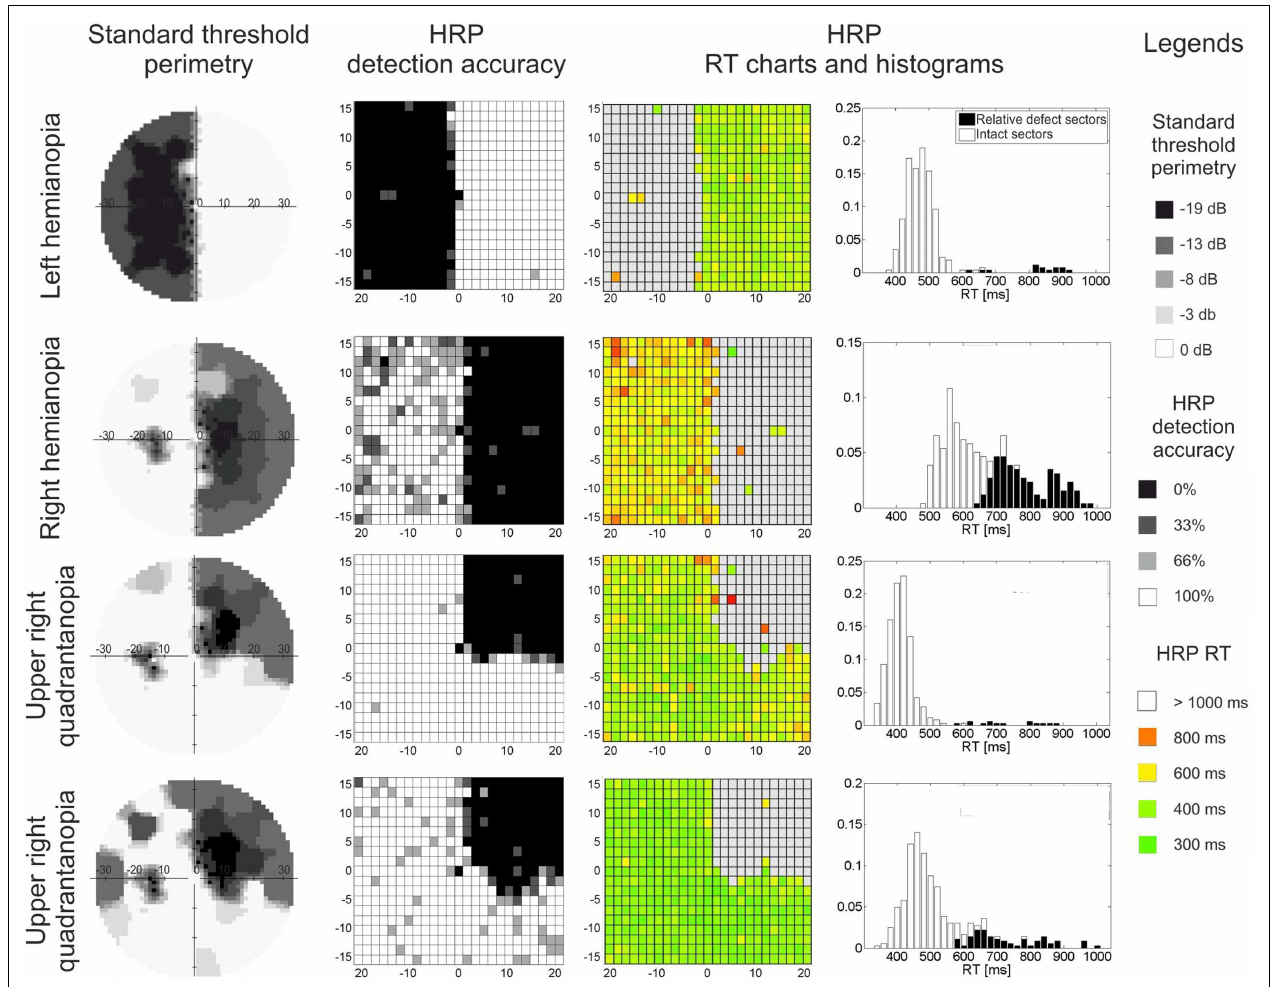
detection, or elevated thresholds), and intact field (white sectors, full detection, low threshold). RT charts and RT histograms show processing speed deficits: (i) patients vary with respect to processing speed in the intact field, and (ii) residual vision areas are impaired when compared with intact sectors. Eccentricity (in degrees of visual angle) is denoted on horizontal and vertical axes in threshold perimetry and HRP